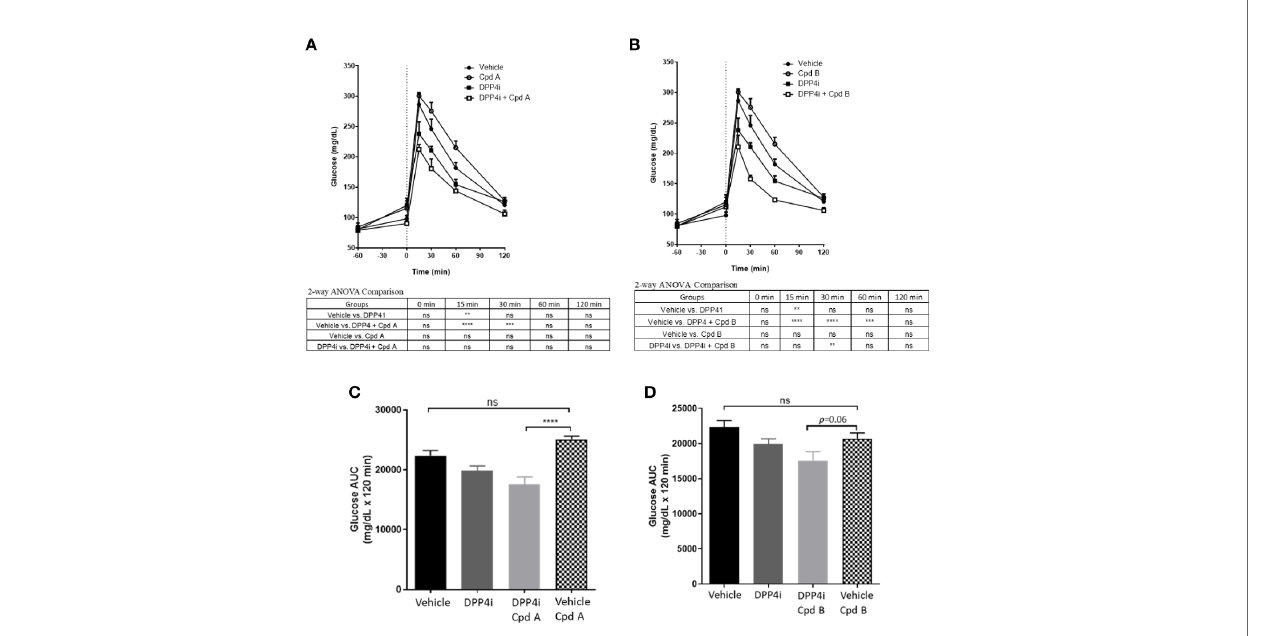
FIGURE 5 | OGTT in C57BL/6J mice. (A) Effect of Cpd A on DPP4i-mediated glucose excursion in C57BL/6J mice; (B) Effect of Cpd B on DPP4i-mediated glucose excursion in C57BL/6J mice; (C) Results of A expressed as Area under the curve (AUC); (D) Results of A expressed as AUC. Data are expressed as mean values ± SD of 6 animals in each group. For Figures (A, B) differences between group means are assessed by Ordinary 2-way ANOVA followed by Tukey ’ s multiple comparison test. The analysis result was shown under each fi gure. For Figures (C, D) , differences between group means are assessed by Ordinary one-way ANOVA followed by Tukey ’ s multiple comparison test. **P = 0.001-0.01, ***P = 0.0001-0.001, ****P < 0.0001; ns, not signi fi